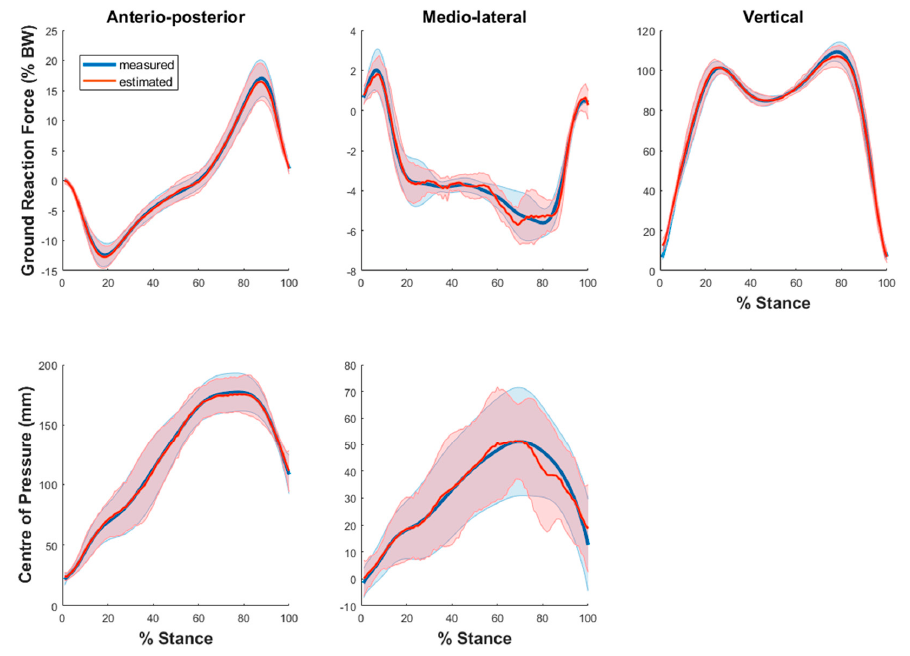
Figure 2. Measured (blue) and estimated (red) GRF ( top row ) and COP ( bottom row ) averaged across all the trials and subjects. GRF was normalised with respect to BW and COP illustrated in mm. Shaded area represents one standard deviation of the subject means.